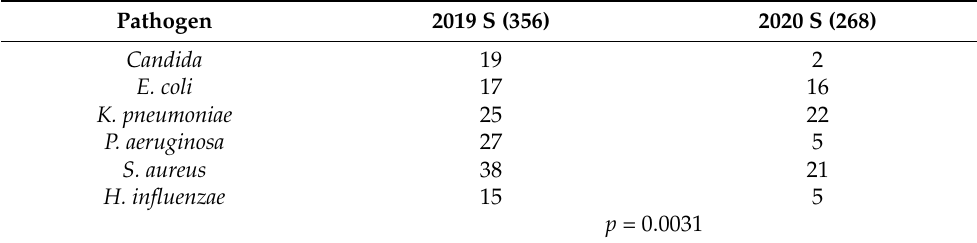
Table 5. Bronchoalveolar lavage fluid